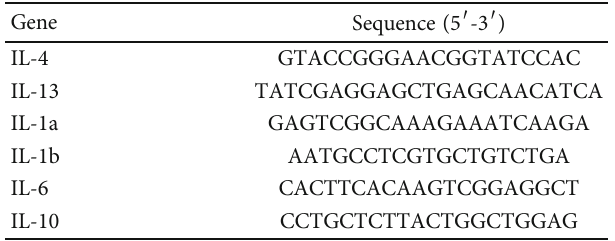
Table 1: The forward primer sequences for qRT-PCR.